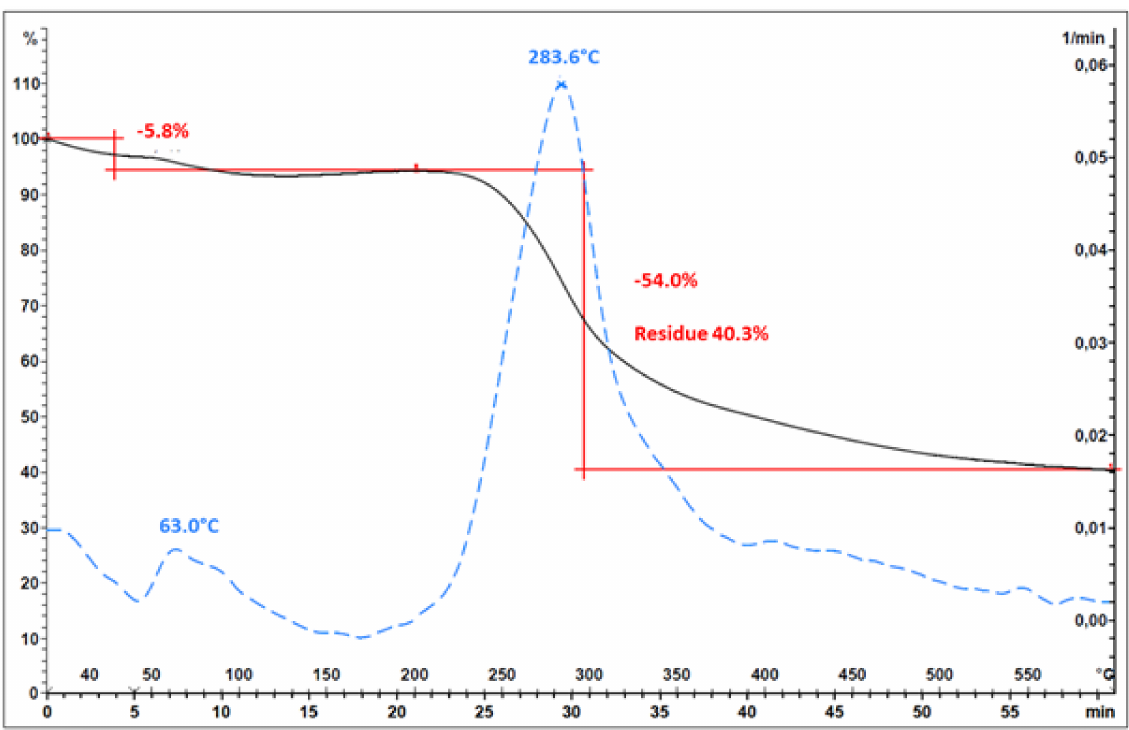
Figure 2. Thermograms of produced COS BioA187. Black solid curves represent thermogravimetric analysis (TGA), blue dotted lines represent the derivatives and in red the weight loss. Infrared absorbtion spectra of produced COS